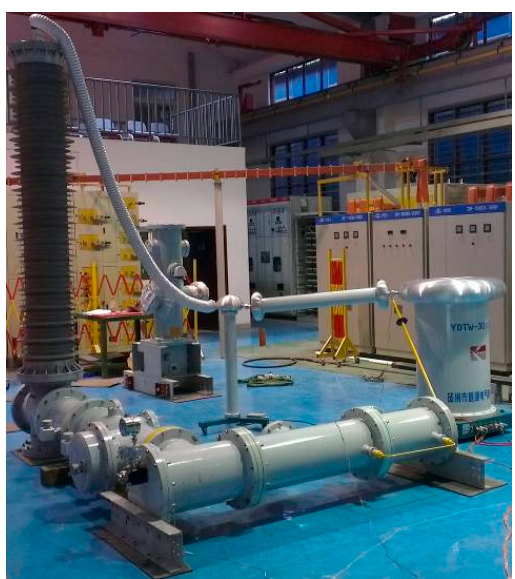
Figure 1. Photograph of the GIS tank.